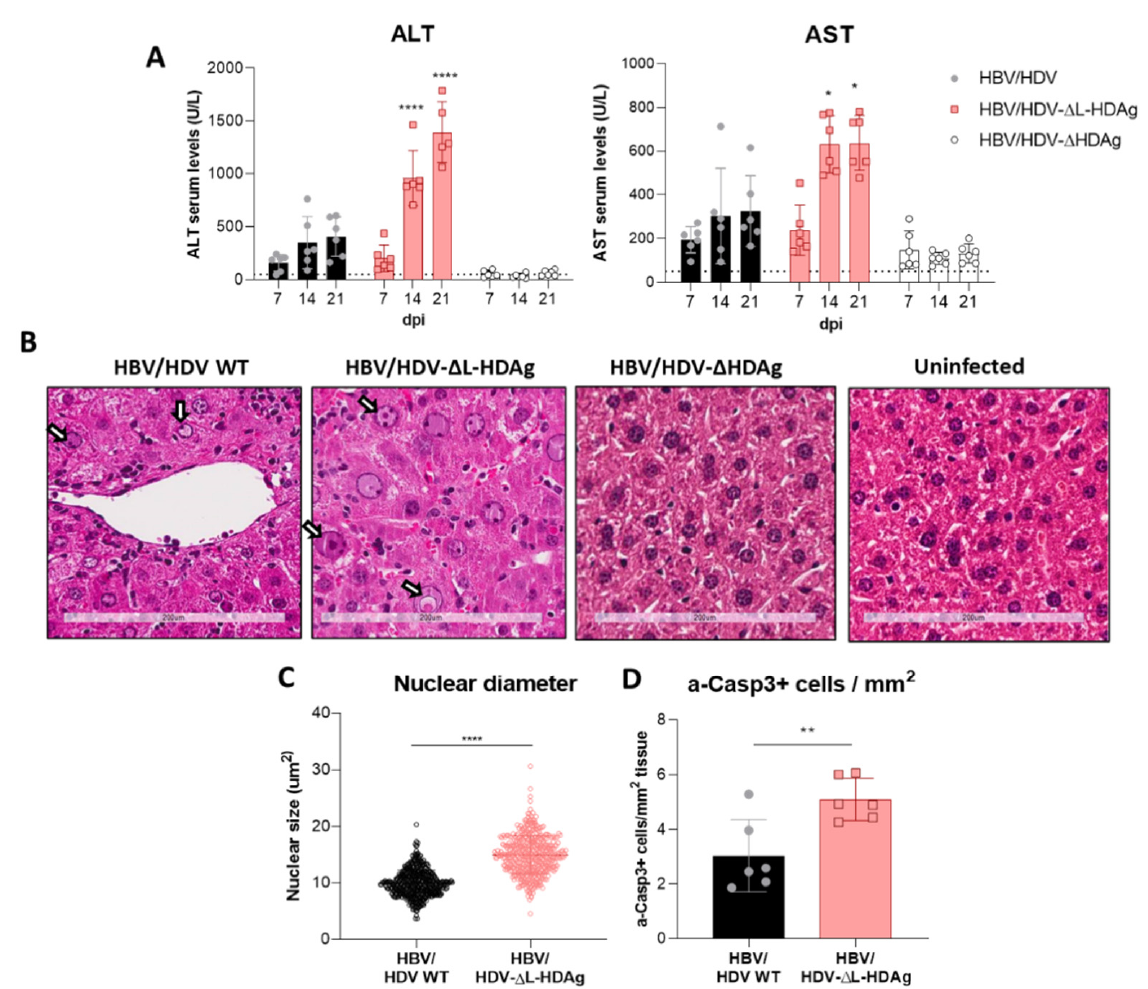
Figure 4. The expression of S-HDAg in the absence of L-HDAg resulted in increased liver damage. ( A ) Peripheral blood was collected every 7 days after vector injection to measure ALT and AST concentration in serum. Individual data points and mean values ± standard deviation are plotted; significant differences between groups at each time point are determined by a two-way ANOVA, followed by Bonferroni’s multiple-comparison test. ( B ) Liver sections from AAV-HBV/HDV WT-, AAV-HBV/HDV- ∆ L-HDAg-, AAV-HBV/ HDV- ∆ HDAg-injected mice that obtained 21 dpi were analyzed by H&E staining; an image of an uninfected liver was included as a control. Degenerated nuclei (white arrow) were observed in both groups of mice but were more abundant upon infection with the HDV- ∆ L-HDAg mutant. Scale bar: 200 µ m. ( C ) The nuclear diameter was significantly bigger when only S-HDAg was expressed. Significant differences were found by performing an unpaired t -test. ( D ) Immunostaining against cleaved caspase 3 revealed that S-HDAg overexpression exacerbates hepatocyte death by apoptosis. Statistical analysis using a Mann–Whitney test revealed differences between the two groups (* p < 0.05, ** p < 0.01, **** p <